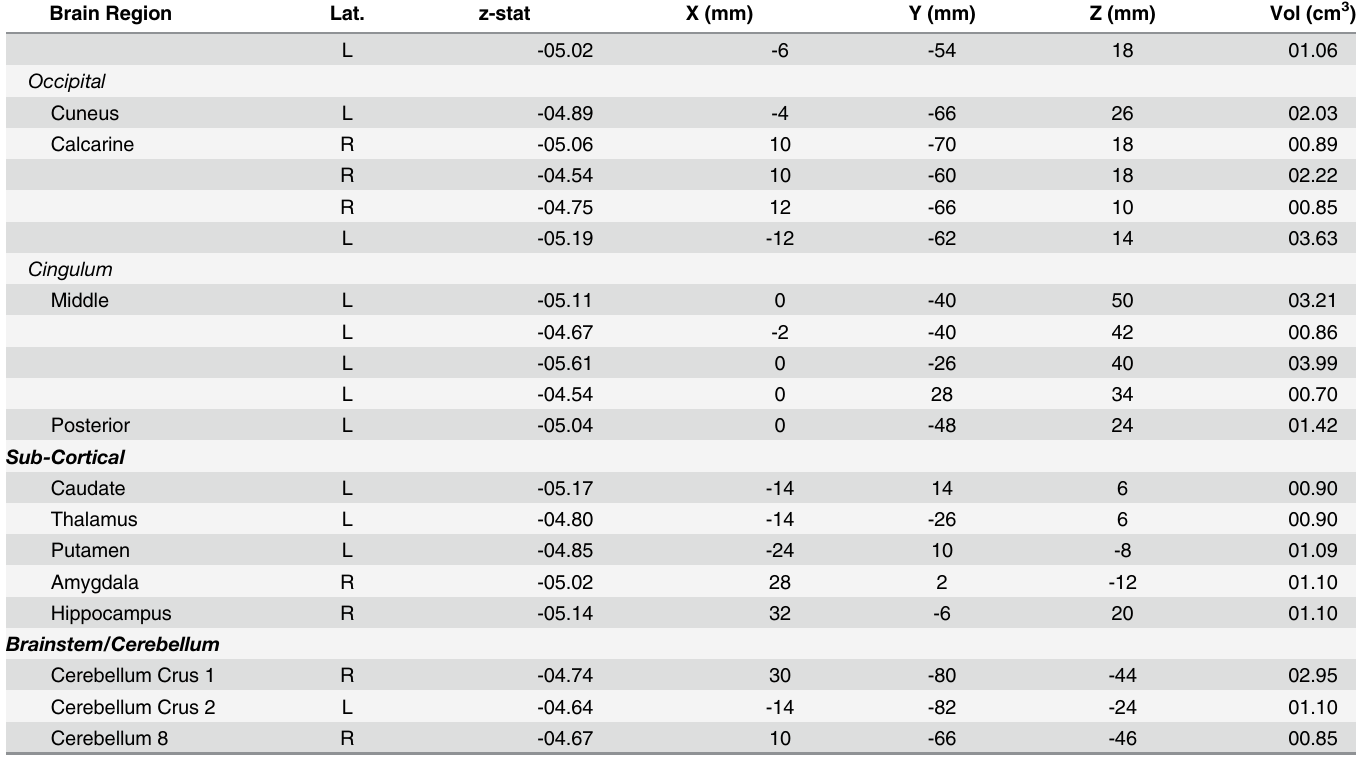
with CGRP receptor-antagonists reduce capsaisin-evoked sensitization, while post-treatment with CGRP dose-dependently restores capsaisin-evoked sensitization in rats [37]. Collectively, these data suggests that CGRP exerts its action outside of the BBB and modulates sensory pro- cessing, without direct activating or sensitizing effects.